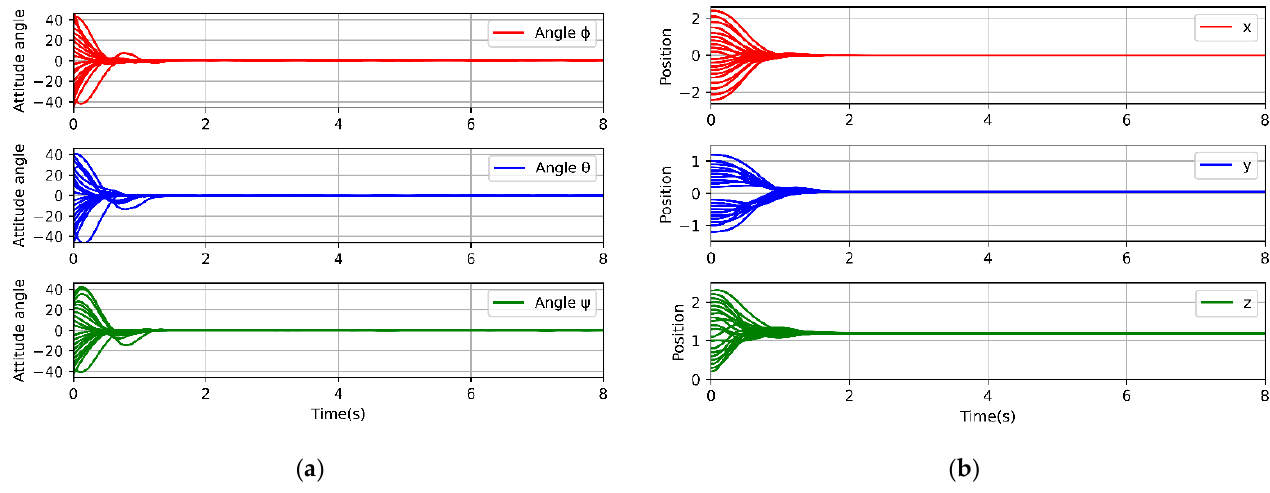
Figure 12. ( a ) PPO-PPD attitude control performance test in 20 different initial states. ( b ) PPO-PPD position control performance test in 20 different initial states.